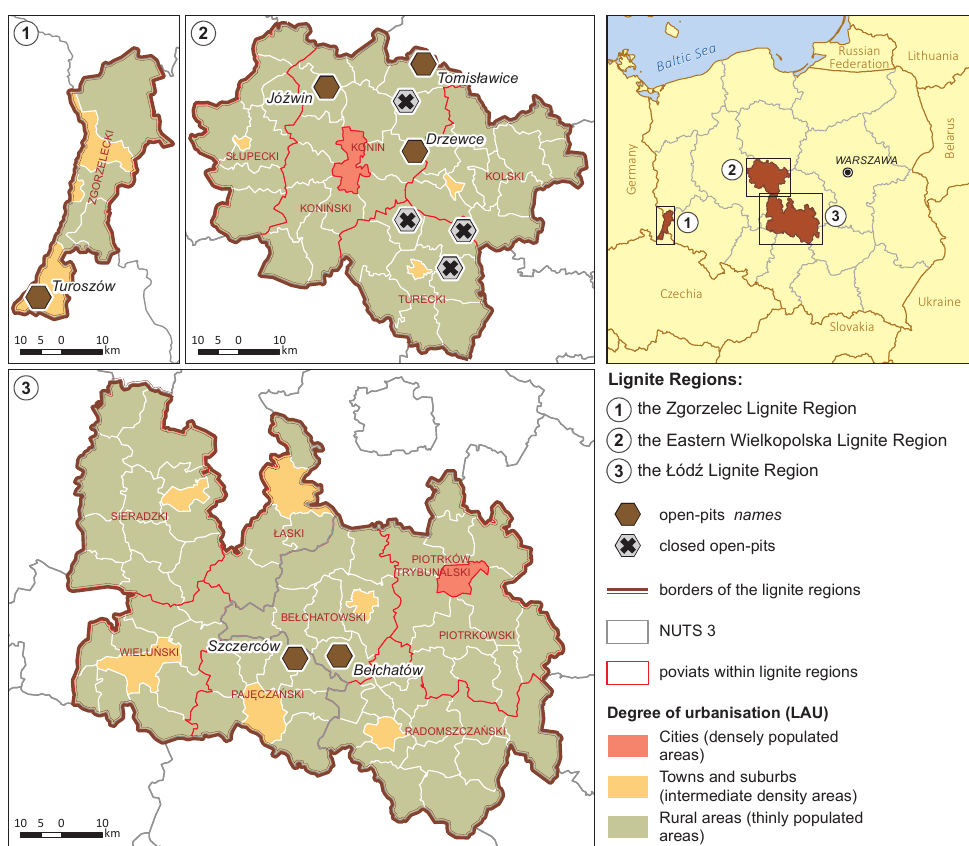
Figure 1. The location and administrative structure of the regions under analysis. The Zgorzelec Lignite Region, which is the smallest region, has the highest population density (over 105 people/km 2 ) and the highest level of urbanisation (based on Eurostat data from 2021), despite the fact that there are no big cities in the region. The largest towns are Zgorzelec and Bogatynia (with 29.8 and 22.6 thousand people, respectively). In Eastern Wielkopolska, the average population density is 97 people/km 2 , and the main city is Konin (72.5 thousand people), located in the central part of the region. In the Łód´z Lignite Region, the population density is the lowest (below 88 people/km 2 ), as agricultural areas prevail in that region. The main city of the region is Piotrków Trybunalski (72.2 thousand people), located in its eastern part, and the main towns are Bełchatów (56.4 thousand people), Radomsko (45.4 thousand people) and Sieradz (41.4 thousand